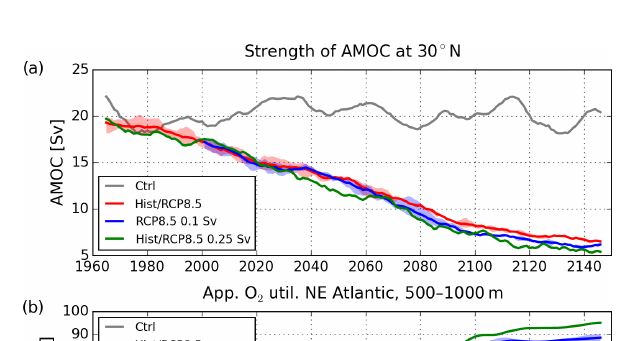
the density though is indicated in the northern region of in- fluence ( − 0 . 35 kg m − 3 ; Table 2), where the cooling effect is weakest and the water temperature thus still increases due to the increasing radiative forcing. In the south, the remaining influence of warm subtropical water and Mediterranean over- flow water induces a more moderate change ( − 0 . 19 kg m − 3 ). Because of the stronger density drop in the north than in the south, the meridional density gradient